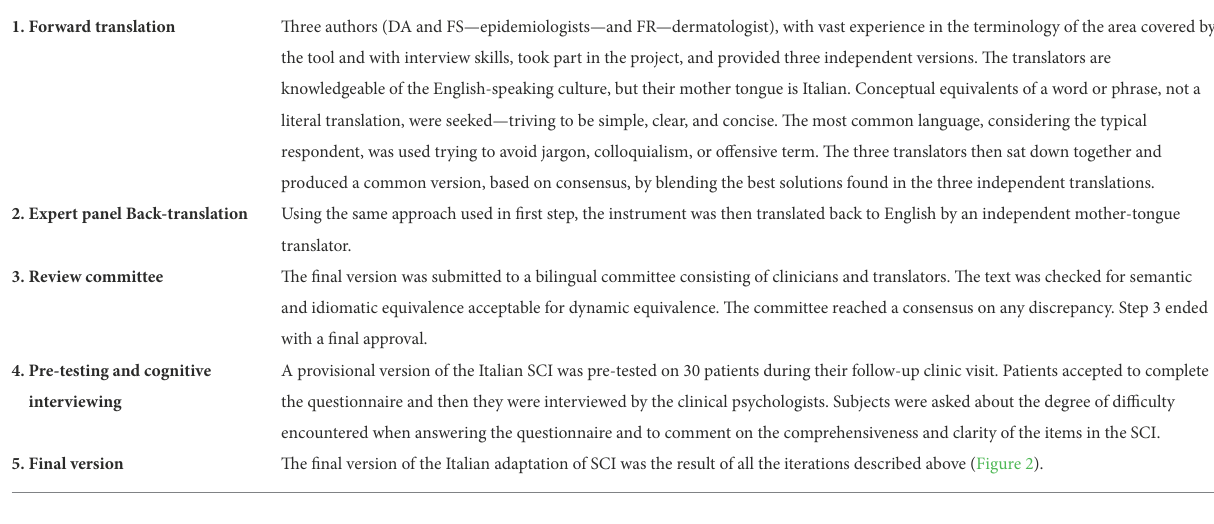
TABLE 1 SCI process of translation and